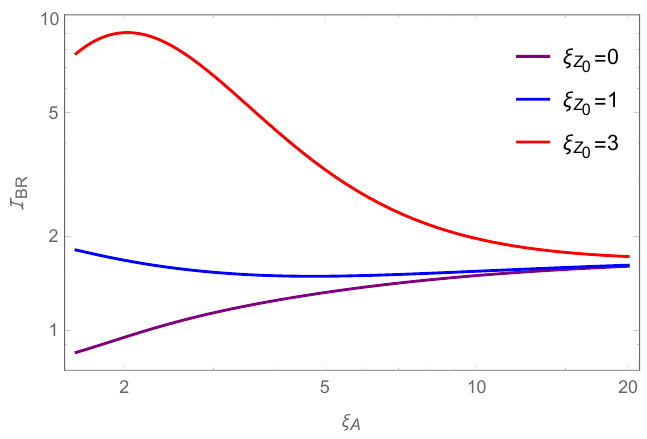
+ (cid:11) H (cid:24) 2 ) =(cid:24) A ] as a function of (cid:24) A and for di(cid:11)erent values of A Z 0 2 6 = 0, we set (cid:11) H = 0